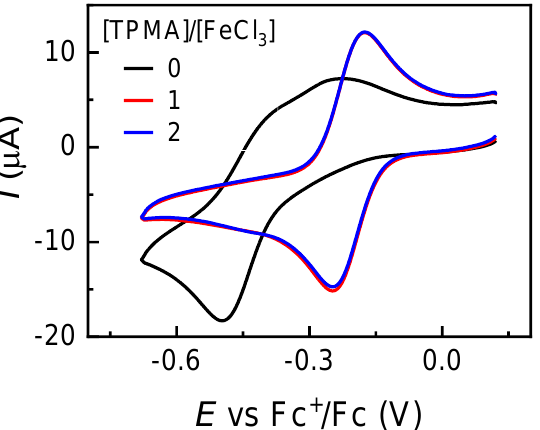
Figure 6. Cyclic voltammetry of 1.1 mM FeCl 3 in DMF + 0.1 M Et 4 NBF 4 recorded on a GC electrode at v = 0.2 V/s and T = 25 ◦ C, before and after addition of TPMA.